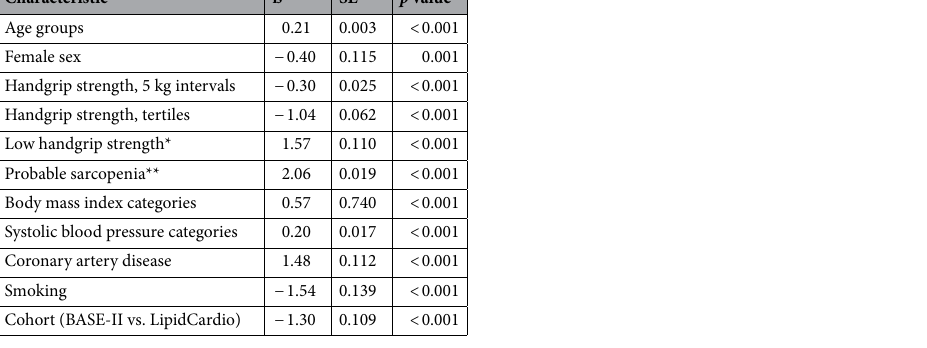
Table 2. Univariate linear regression coefficients of handgrip strength and other covariables with pulse wave velocity. ß = regression coefficient, SE standard error, BASE-II Berlin Aging Study II, *below lowest tertile versus rest, **according to the EWGSOP2 sarcopenia cut-off